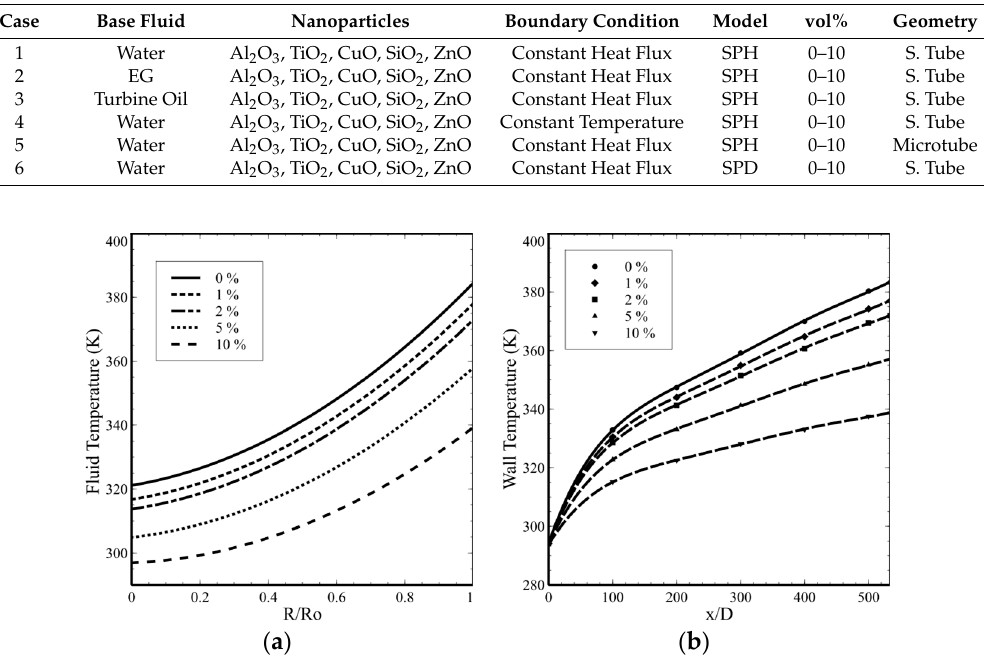
Figure 2. Effect of nanoparticle concentration in tube flow: ( a ) fluid temperature profiles at tube exit; ( b ) axial development of wall temperature.